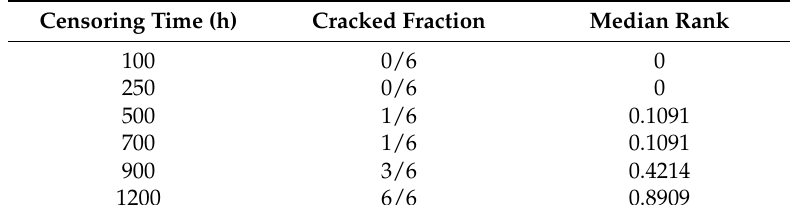
Table 1. Example of a cracking initiation test result with six specimens.